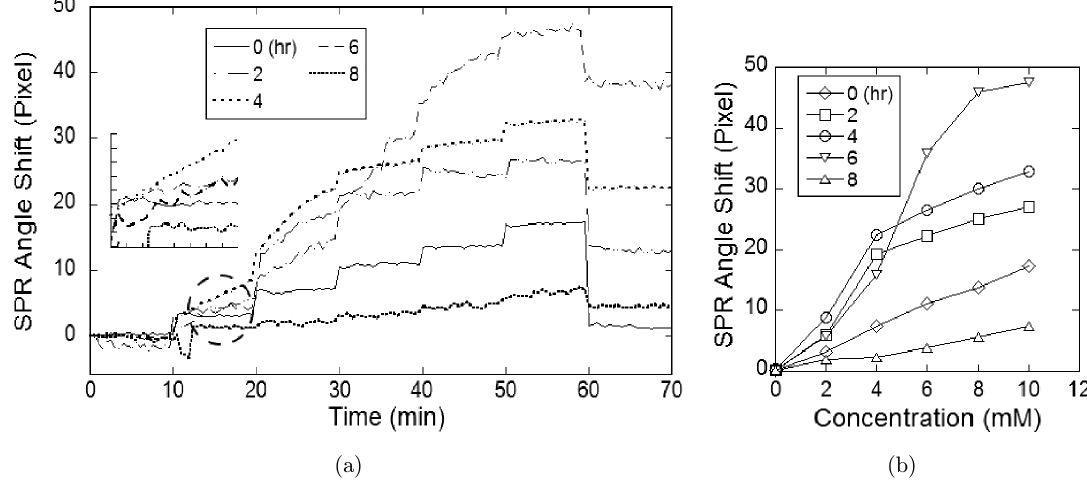
Fig. 4. Comparison of di®erent modi¯cation time. (a) Detecting curve of sucrose using ¯ve sensor chips according to time. (b) Angle shift of di®erent concentration by ¯ve sensor